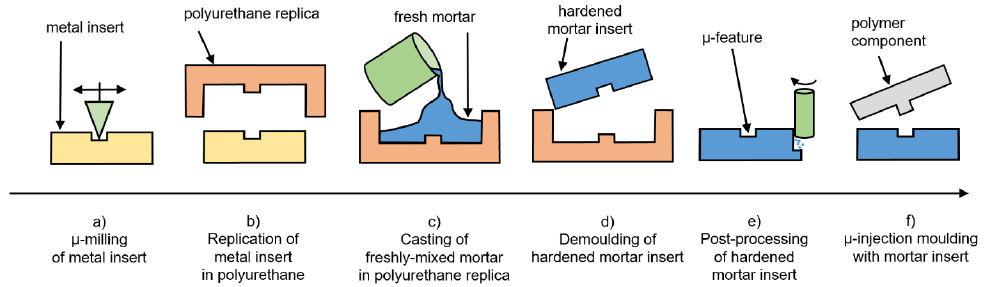
Figure 2. Soft tooling process chain.